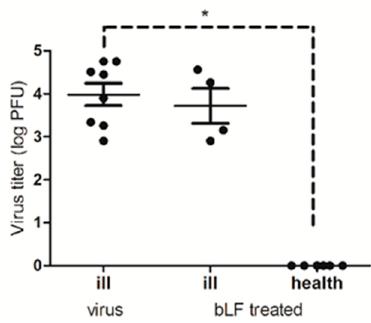
Figure 5. The anti-DENV-2 activity of bLF in suckling mice. One-day old suckling mice were inoculated intracranially with 1 × 10 4 PFU of DENV-2 or a mixture of DENV-2 and 200 μ g bLF by intracranial (i.c.) injection. These mice were sacrificed at 13 days post-inoculation, and the brain was collected for virus titer determination by plaque assay.